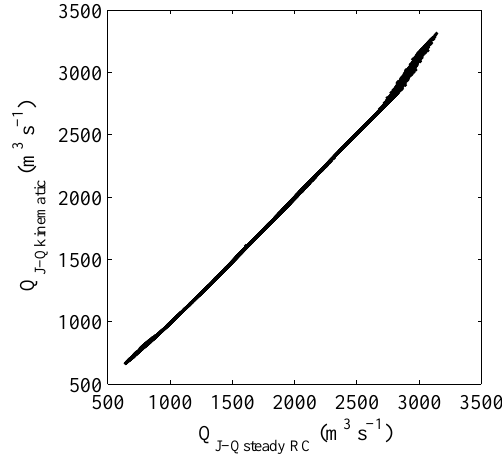
Fig. 14. Comparison of discharge estimates obtained using the Jones formula based on Q kin (uniform channel geometry assump- tion) and those based on Q 0 (discharge taken from the steady flow rating curve Q 0 = 125 . 98 × (h + 1 . 5 ) 1 . 256 ) for the whole observa- tion period. The small deviation confirms that the two approaches yield similar results. Only during peak discharges, the use of Q 0 instead of Q kin can result in slightly different rating curve-based estimates of the